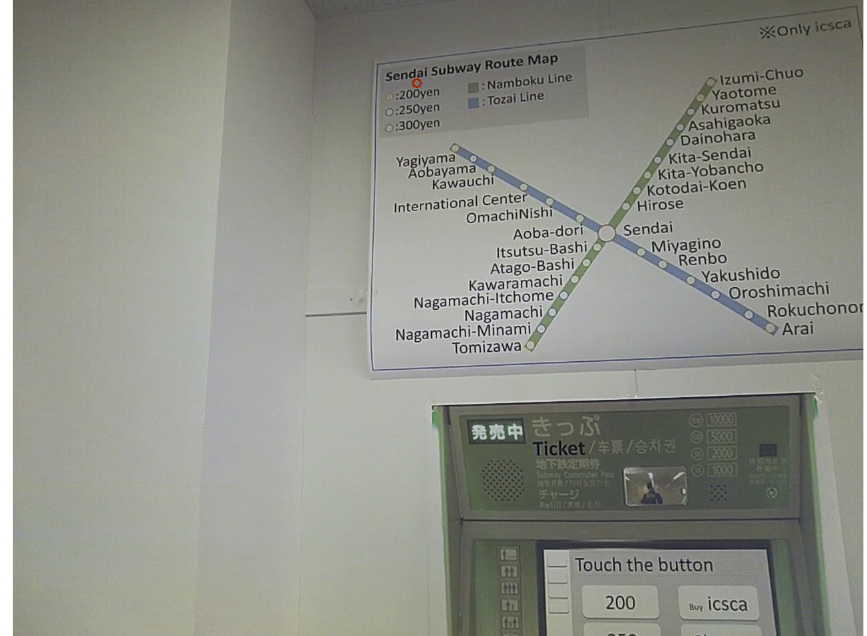
Figure 7. Example of failure caused by misdetection of viewpoint. Although the subject was looking at the guidance of the “Sendai Subway Route Map”, the detected viewpoint was slightly shifted